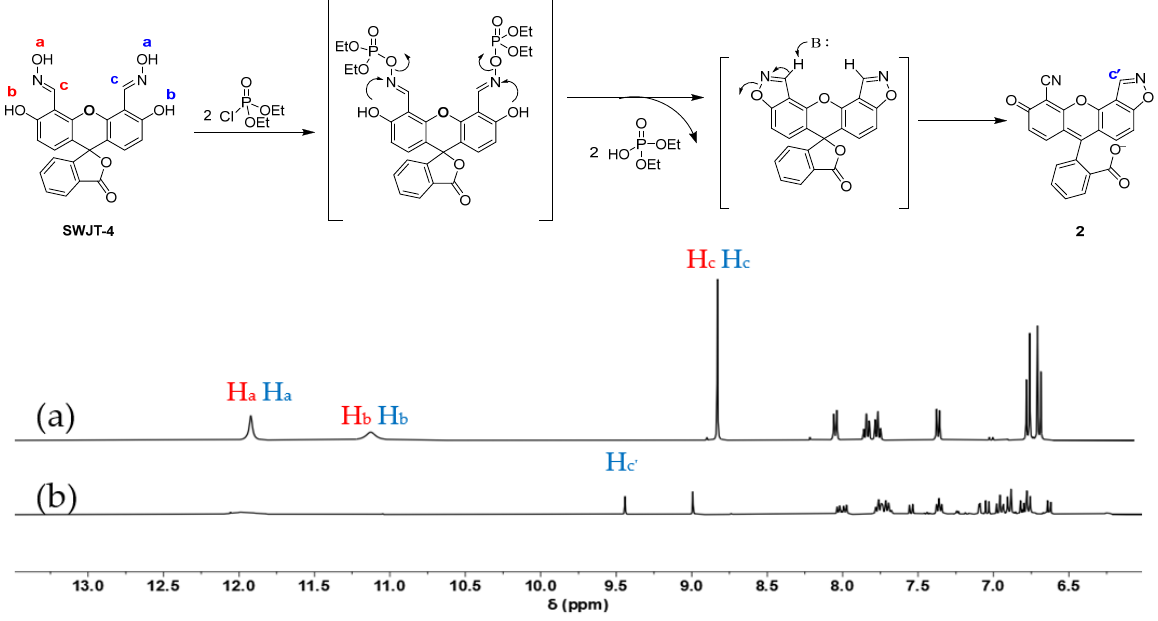
Figure 3. Partial 1 H NMR spectra of ( a ) SWJT-4 and ( b ) SWJT-4 + DCP in DMSO- d 6 .